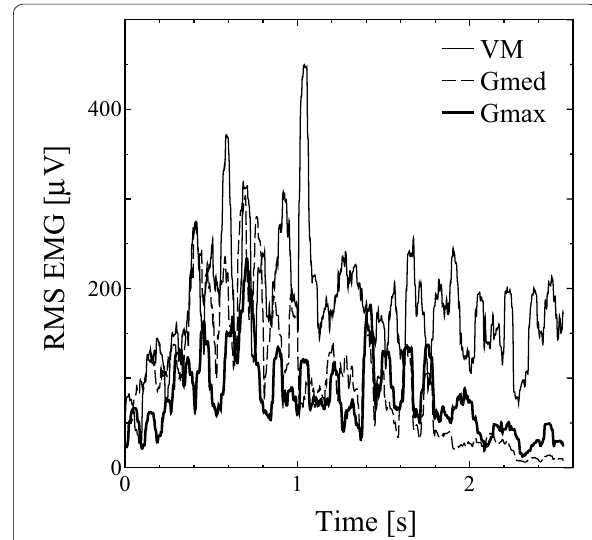
Fig. 22 RMS EMG of an ACL reconstructed subject during isotonic exercise. The target force was 0 N